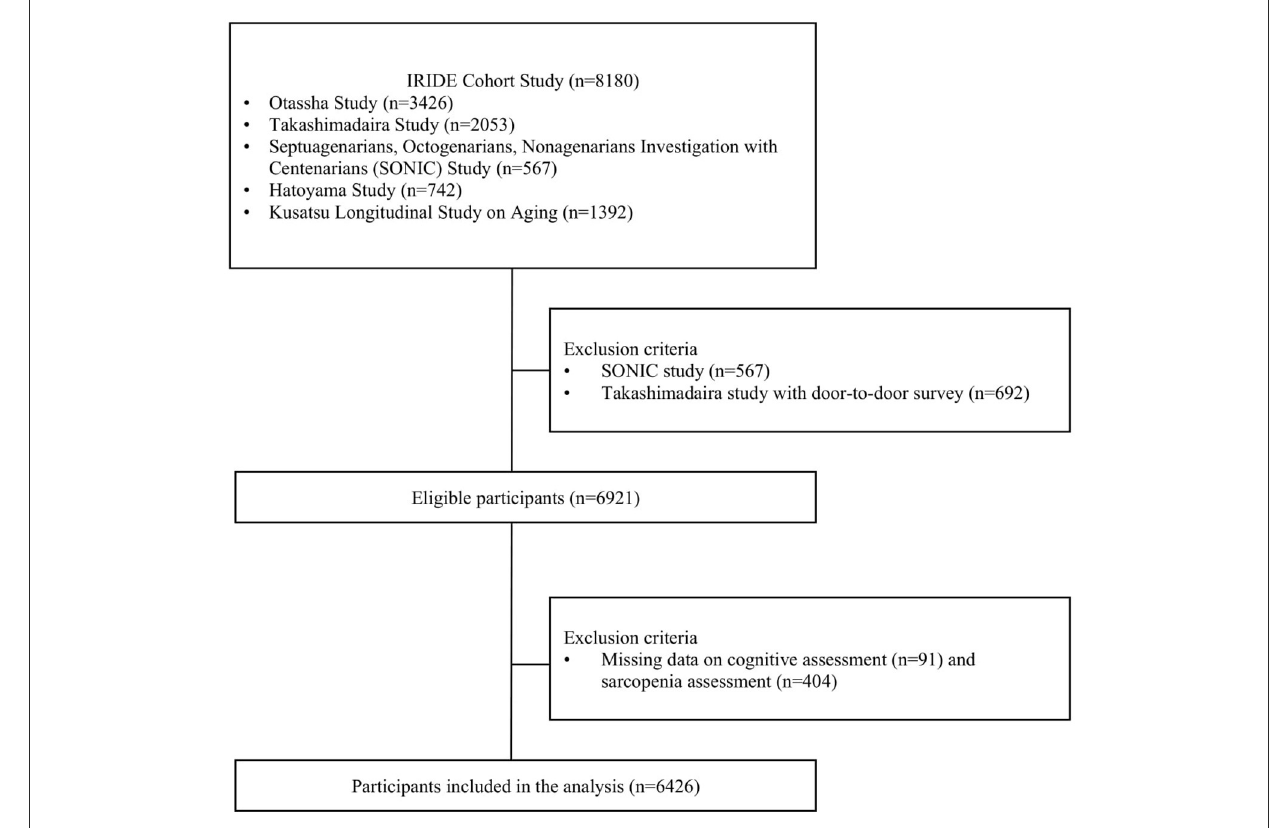
FIGURE1 Flowchart of participant